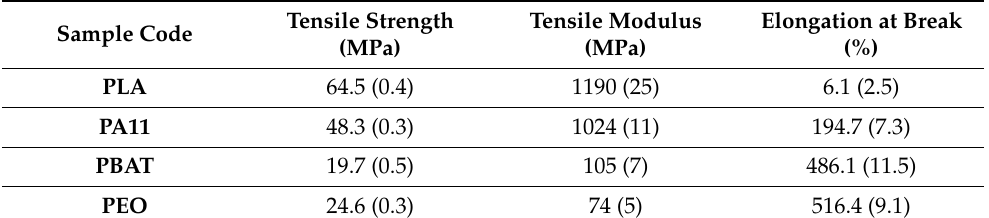
Table 2. Tensile properties of the neat polymers.